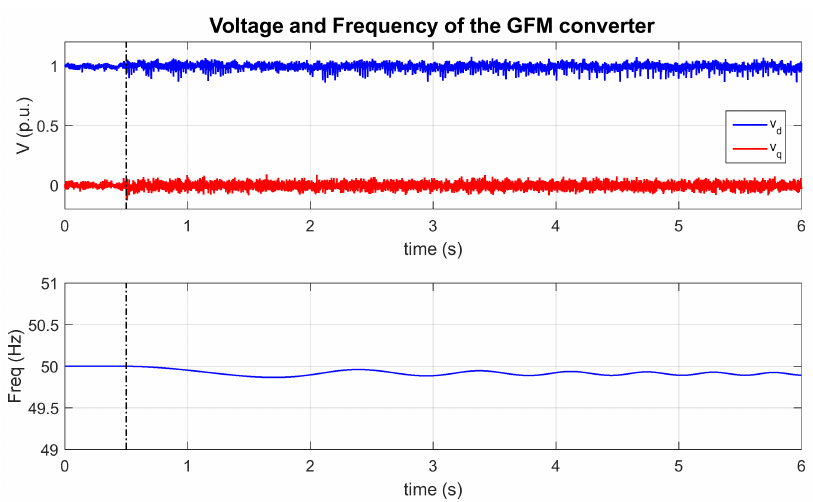
Figure 19. Voltage and frequency during the transition to islanded